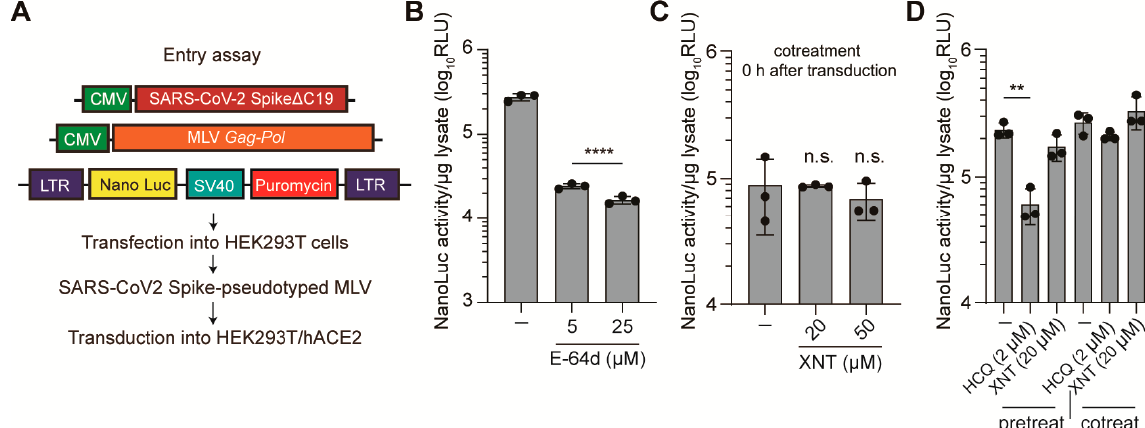
Figure 2. XNT does not interfere with SCoV2 entry. ( A ) Schematic diagrams of plasmids used for the generation of the SCoV2 spike protein-pseudotyped MLV. ( B ) Validation of the pseudotyped virus entry assay. Inhibition of the SCoV2 S protein-pseudotyped MLV by a cathepsin (a cysteine protease) inhibitor E-64d. ( C , D ) HEK293T cells transiently expressing hACE2 were treated with XNT or a lysosomotropic agent hydroxyclroquine (HCQ) known to block SCoV2 entry, 0 h after (co-treatment) or 1 h before (pre-treatment) transduction with the pseudotype virus, prior to determination of nano- luciferase activity at 60 h post-transduction. Data are mean ± SD from three independent experiments. ( − ), DMSO (0.1%) vehicle only-treated. ** p < 0.01; **** p < 0.0001; n.s., not significant.